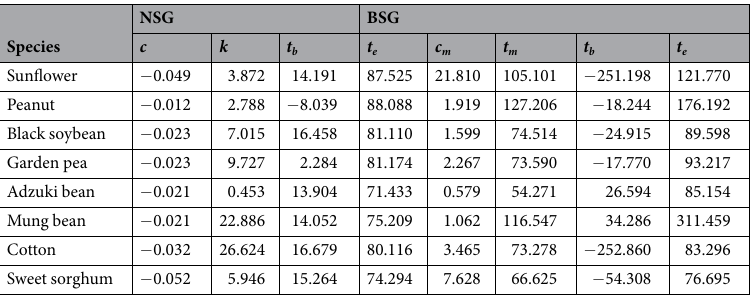
Table 2. Estimated parameters of the new and beta sigmoidal growth models for the growth datasets of crop species. NSG and BSG represent the new sigmoidal growth model and the beta sigmoidal growth model in Eq. (4),